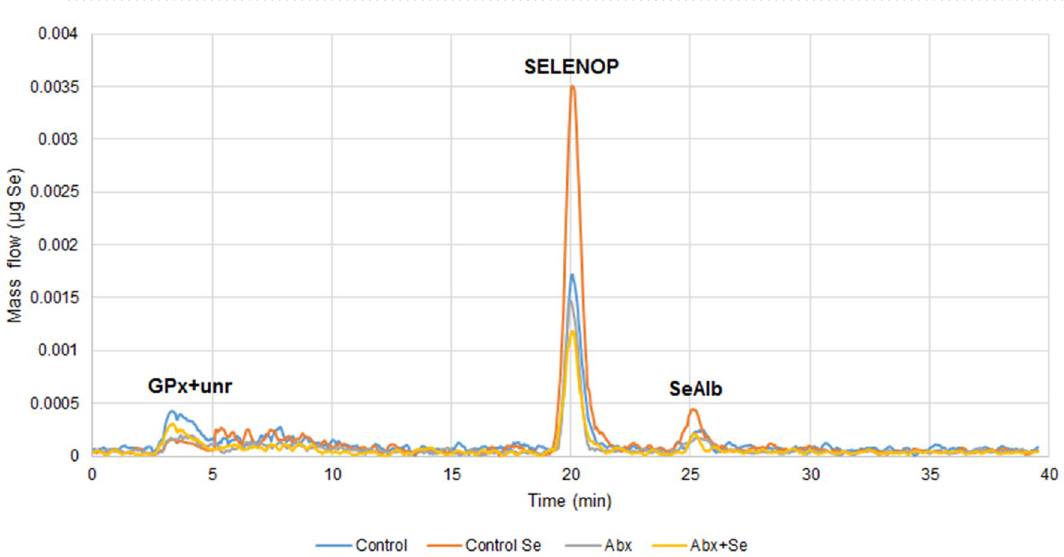
Figure 2. Selenium mass flow chromatogram obtained from testicular tissues of